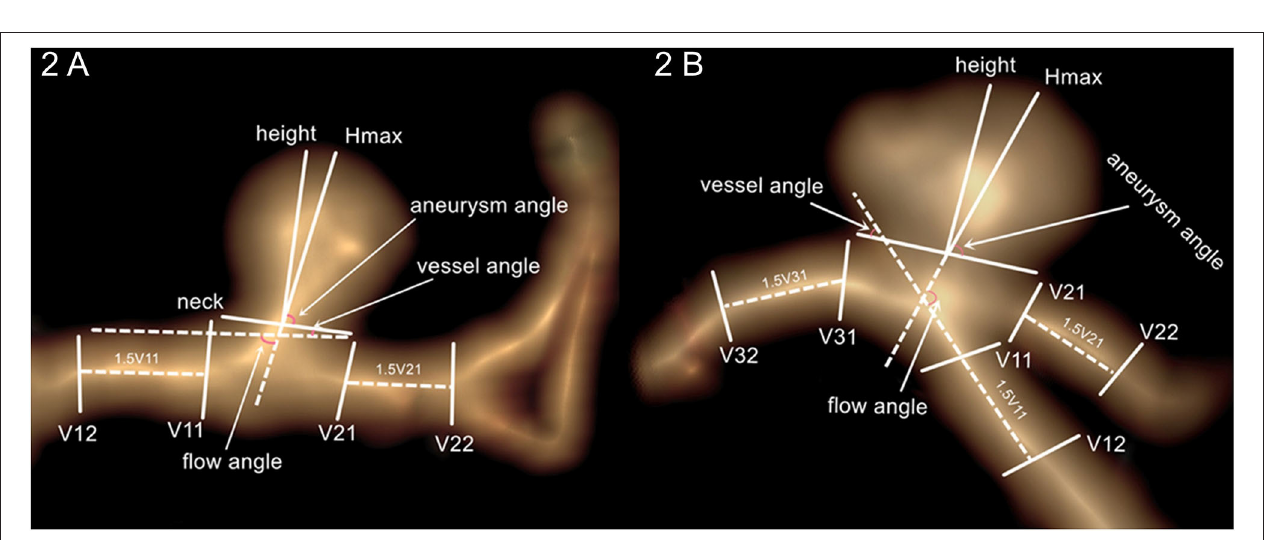
neck. Flow angle was the angle between the blood flow of the parent artery and aneurysm height line. These aneurysm parameters are measured, and the descriptions are shown in Figure 2